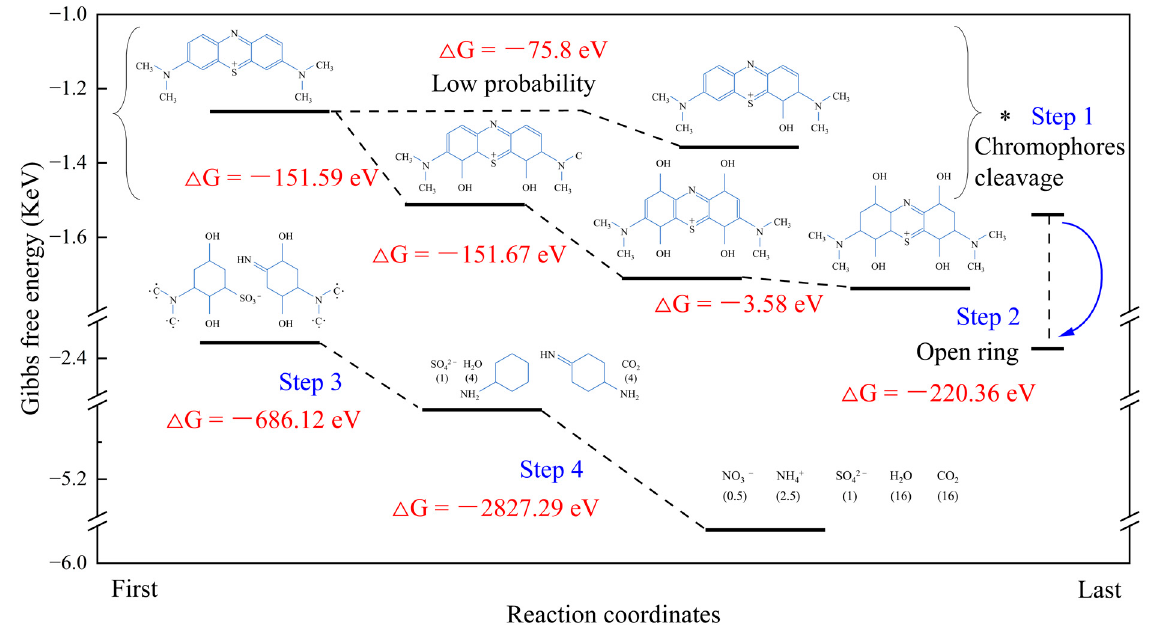
Figure 13. Theoretical calculation and Gibbs free energy of MB-degradation by MM-CaTiO 3 .